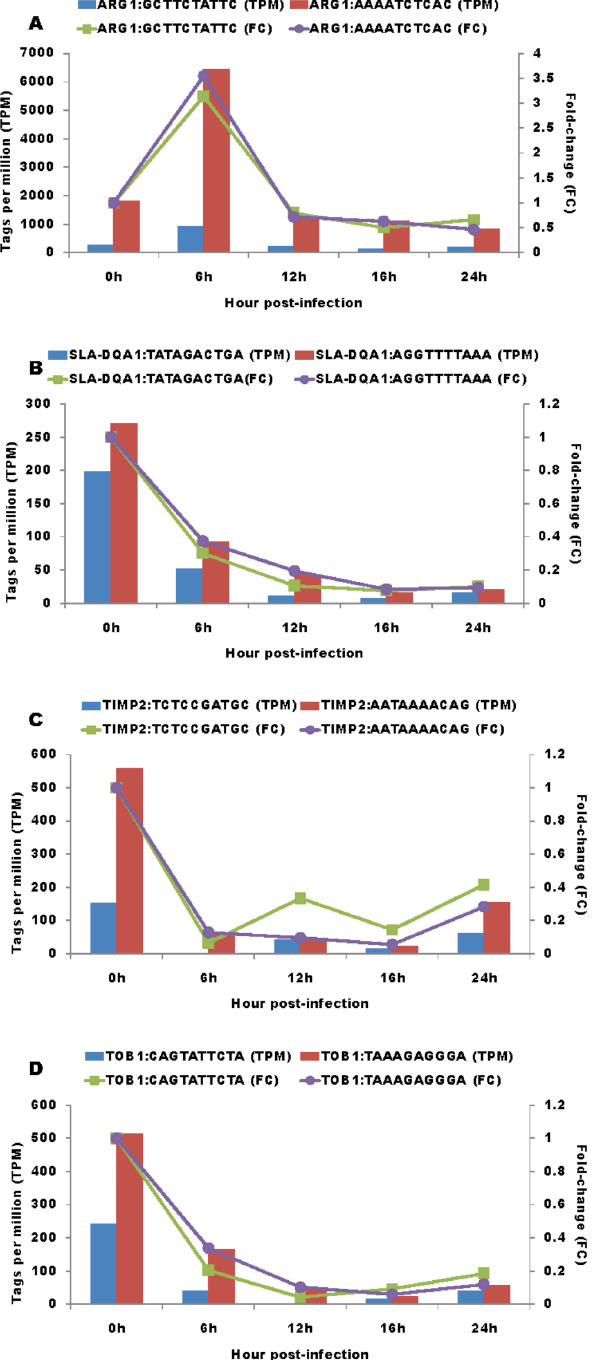
Figure 2. Fold change in TPM for genes with multiple tags due to mRNA isoforms. TPM and fold changes for two tags in ARG1 (A), SLA-DQA1 (B), TIMP2 (C) and TOB1 (D) representing different mRNA isoforms at 0, 6, 12, 16 and 24 hours post-infection.